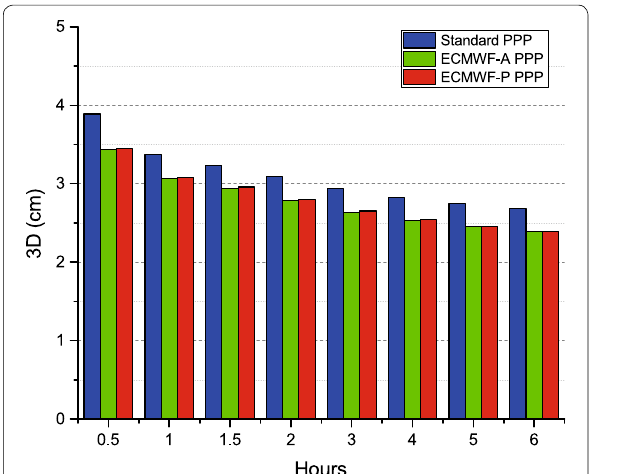
Fig. 4 The 3D RMS values of BeiDou/GPS PPP results after the processing of different session length (0.5, 1, 1.5, 2, 3, 4, 5, 6 h) from the MGEX stations exhibited in Fig. 1 over a sample period from February 6 to March 8, 2016. Blue denotes the standard PPP solution, green and red represent the ECMWF-augmented PPP solution with analysis and prediction data, respectively